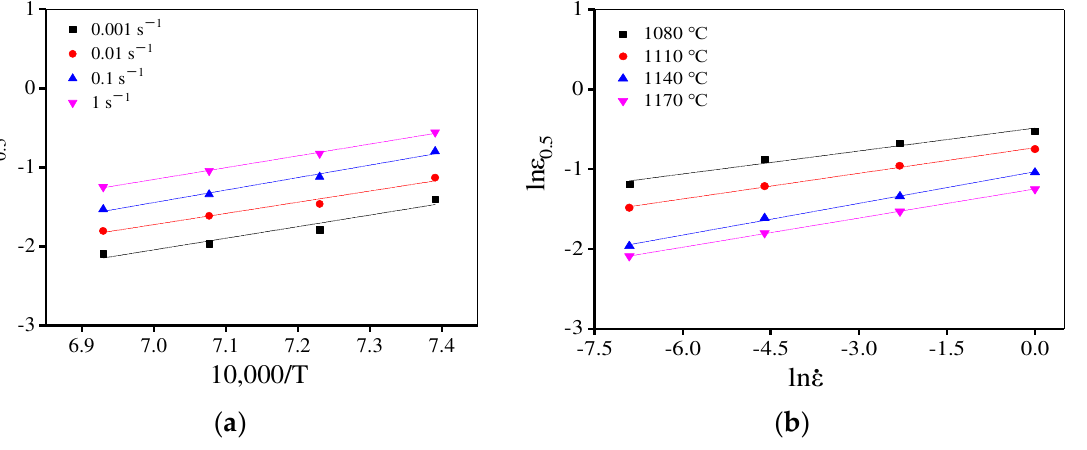
Figure 11. Relationship between ε 0.5 and deformation parameters ( a ) ln ε 0.5 –10,000/T and ( b ) ln ε 0.5 − ln